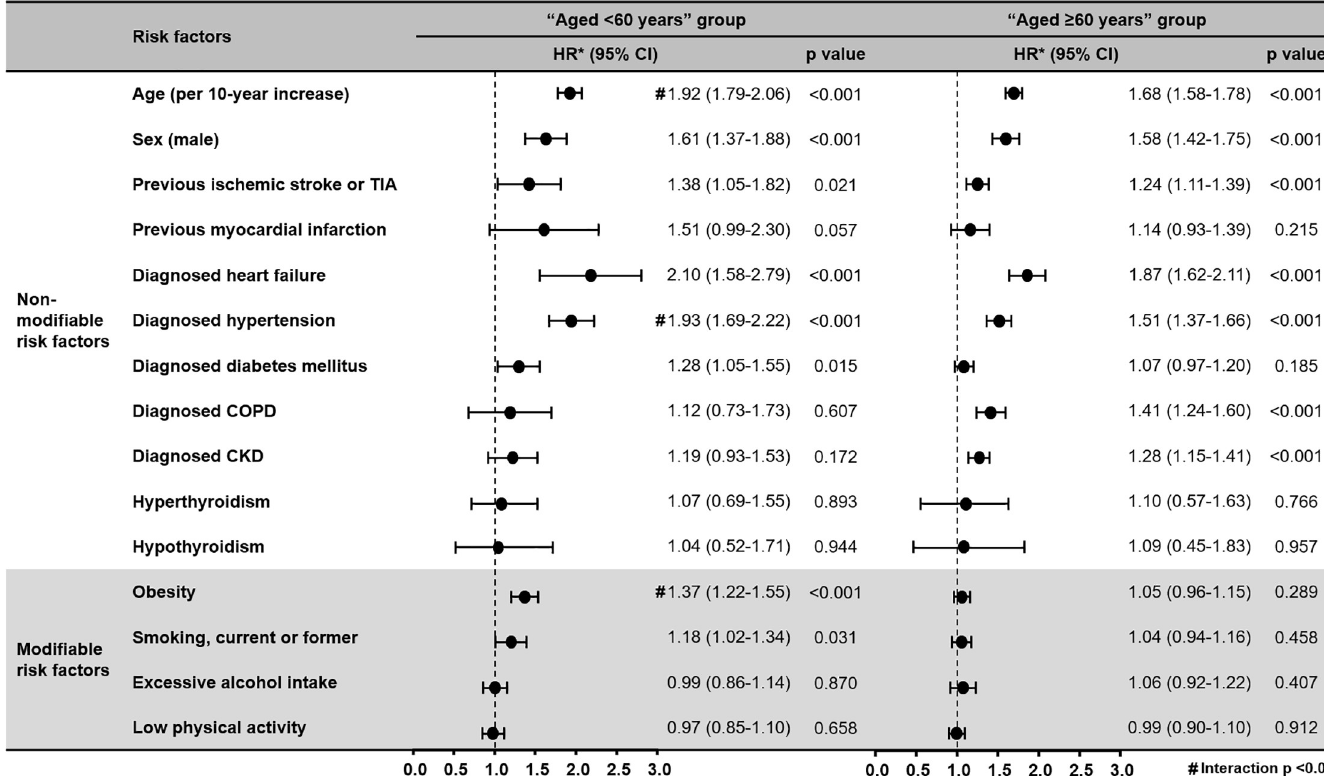
Fig 1. Hazard ratios for new-onset AF according to the risk factors in the “aged < 60 years” and “aged � 60 years” groups. � Hazard ratio for each risk factor was adjusted by the Cox regression model using these variables: age, sex, previous ischemic stroke or TIA, previous myocardial infarction, heart failure, hypertension, diabetes mellitus, COPD, CKD, obesity, smoking, excessive alcohol intake, and low physical activity. # Indicates interaction p-values < 0.05 in testing for interactions with each risk factor between “aged < 60 years” and “aged � 60 years” groups while adjusting for other residual covariables (age, sex, previous ischemic stroke/TIA, previous myocardial infarction, heart failure, hypertension, diabetes mellitus, COPD, CKD, obesity, smoking, excessive alcohol intake, and low physical activity). Among subjects aged < 60 years, the risks of incident AF were significantly higher for age (per 10-year increases), hypertension, and obesity (each interaction p-value < 0.001) compared to those of subjects aged � 60 years. CI, confidence interval; CKD, chronic kidney disease; COPD, chronic obstructive pulmonary disease; HR, hazard ratio; TIA, transient ischemic